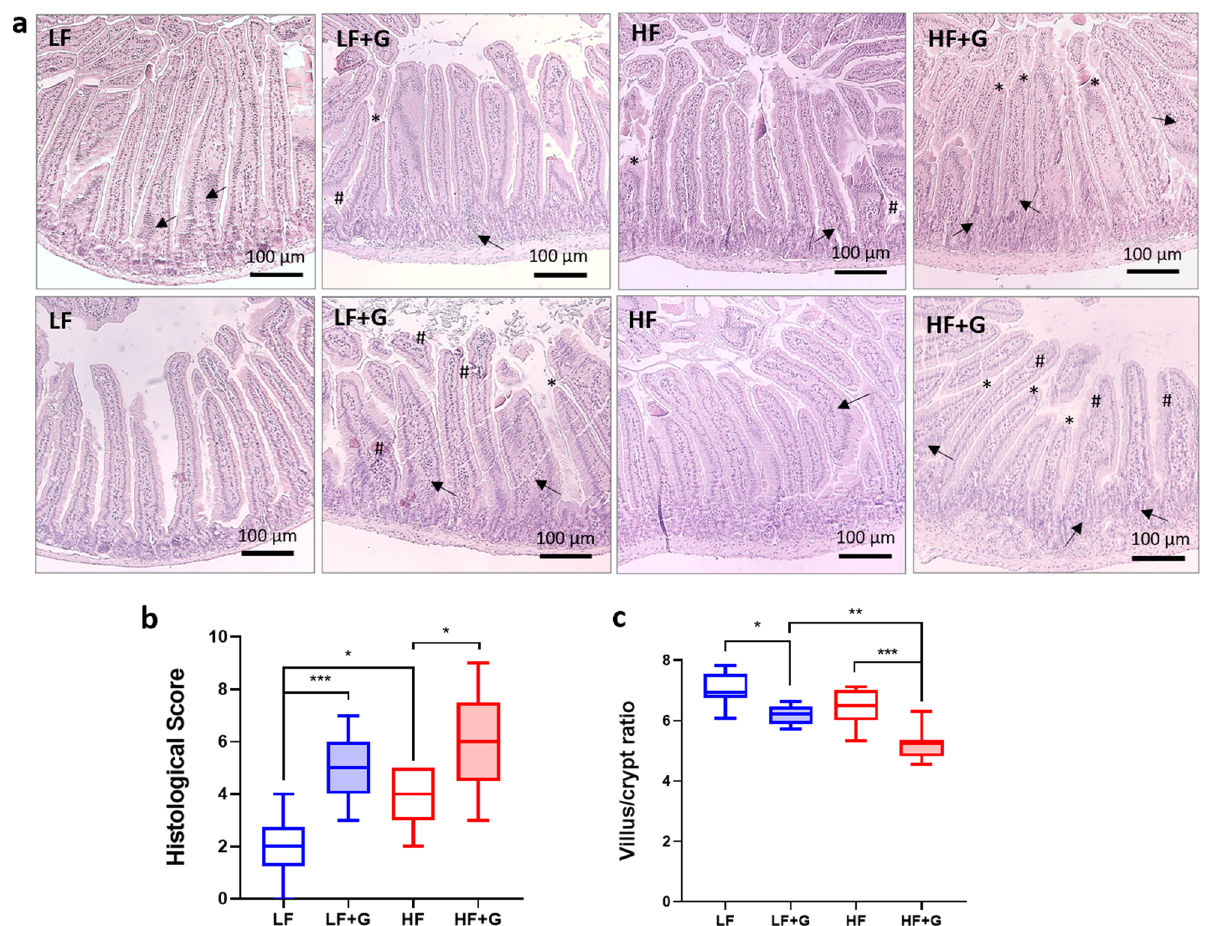
Figure 2. Giardia infection induces damage to the intestinal mucosa in a diet dependent manner. ( a ) H&E stained jejunal sections of control (LF and HF) and infected (LF + G and HF + G) C57BL/6 mice. Scale bar = 100 μm. ( b ) Histological score of the jejunum was determined on day 7 PI in control and infected animals (blind histological examination; scoring criteria: cell infiltration, cell hyperplasia, goblet cell loss, cryptitis, epithelial erosion, ulceration, tissue granulation, irregular crypts, crypt loss, villous damage, and blunting); n = 8/9 per group. ( c ) Morphometric measurements of the jejunal mucosa. Figure illustrates villus height to crypt depth ratios at day 7 post infection; n = 8–9 per group. Arrow ( → ) indicates cell infiltration; (#) indicates epithelial erosion; (*) indicates villous damage/blunting. LF = low fat control mice; LF + G = low fat infected mice; HF = high fat mice; HF + G = high fat infected mice. Data are shown as box plots with min/max whiskers; * p < 0.05, ** p < 0.01, *** p < The trophozoite burden was significantly higher in HF + G compared with LF + G mice ( p < 0.05) (Fig. S2b). No cysts were detected in LF and HFG duodenal sections at day 7 PI. These results suggest that a short-term consumption of HF diet increases the host’s susceptibility to Giardia infection.